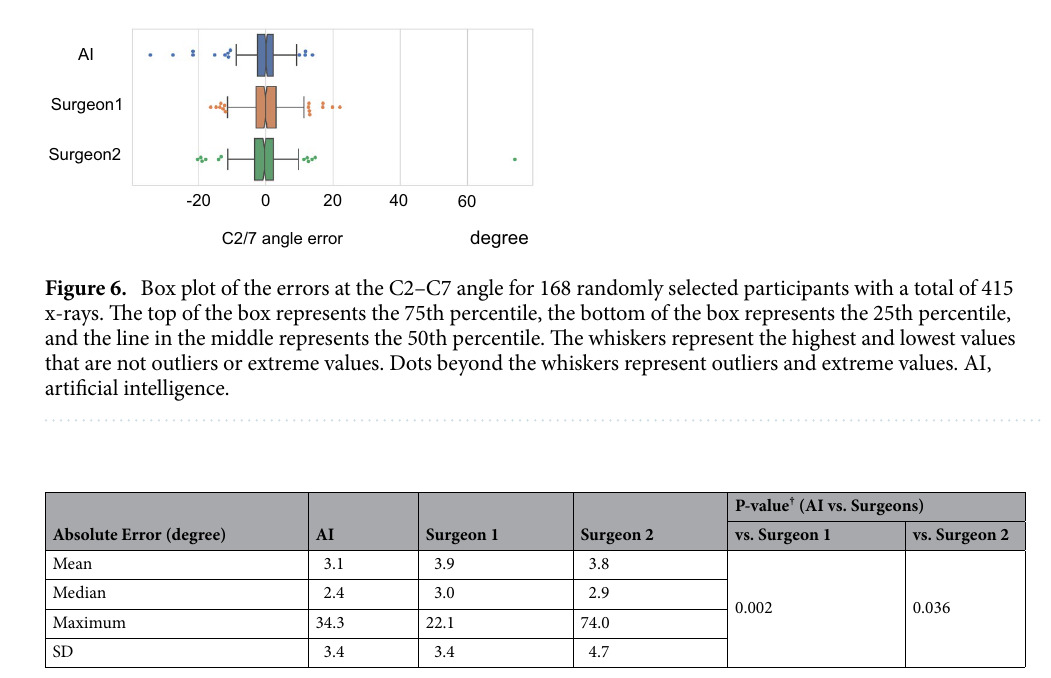
Table 4. Comparison of C2–C7 Angle Errors Between AI and Surgeons for Randomly Selected Cases* *168 cases with a total of 415 x-rays. † The p-values were adjusted by the Bonferroni method. AI, artificial intelligence; SD, standard